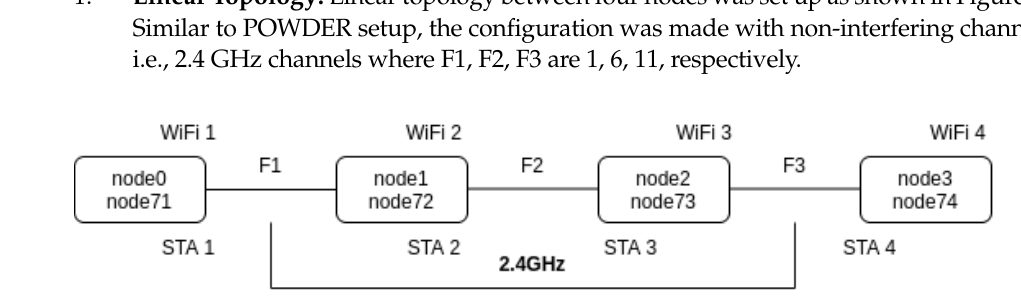
Figure 12. CityLab linear topology node